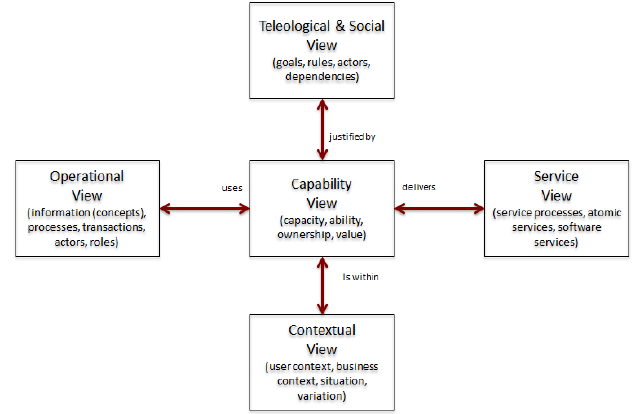
Figure 1: The five interrelated viewpoints for Capability driven design EAI Endorsed Transactions on Internet of